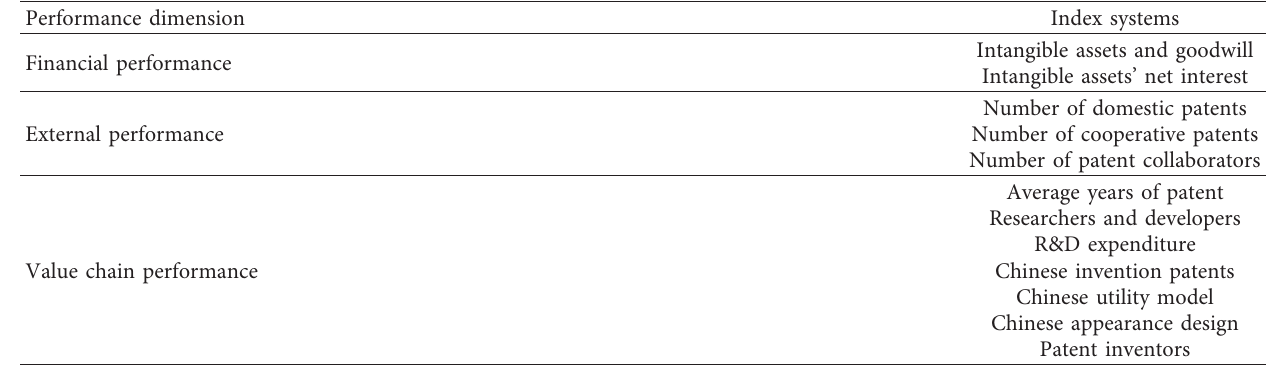
Table 1: Performance index systems of intellectual property value for marine science and technology enterprises.